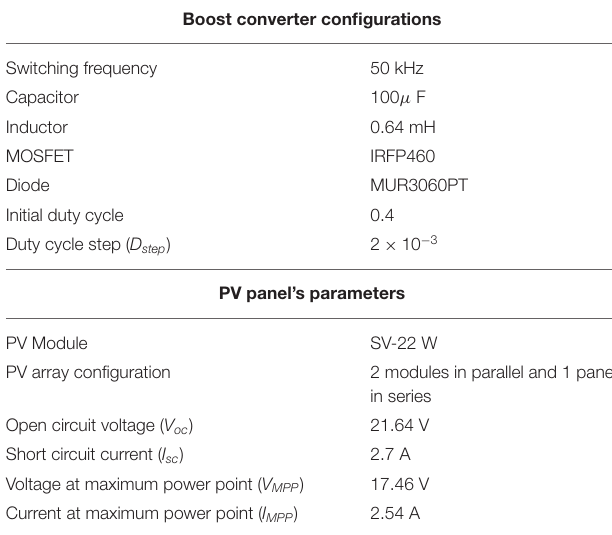
TABLE 3 | Specifications of the MPPT DC-DC boost